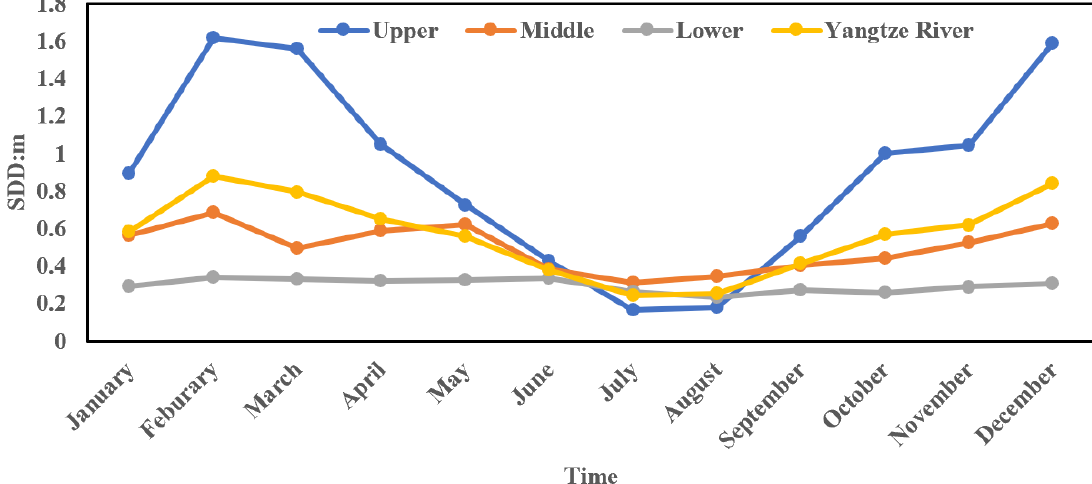
Figure 7. The results of seasonal variation of upper reaches, middle reaches, and lower reaches of Yangtze River.